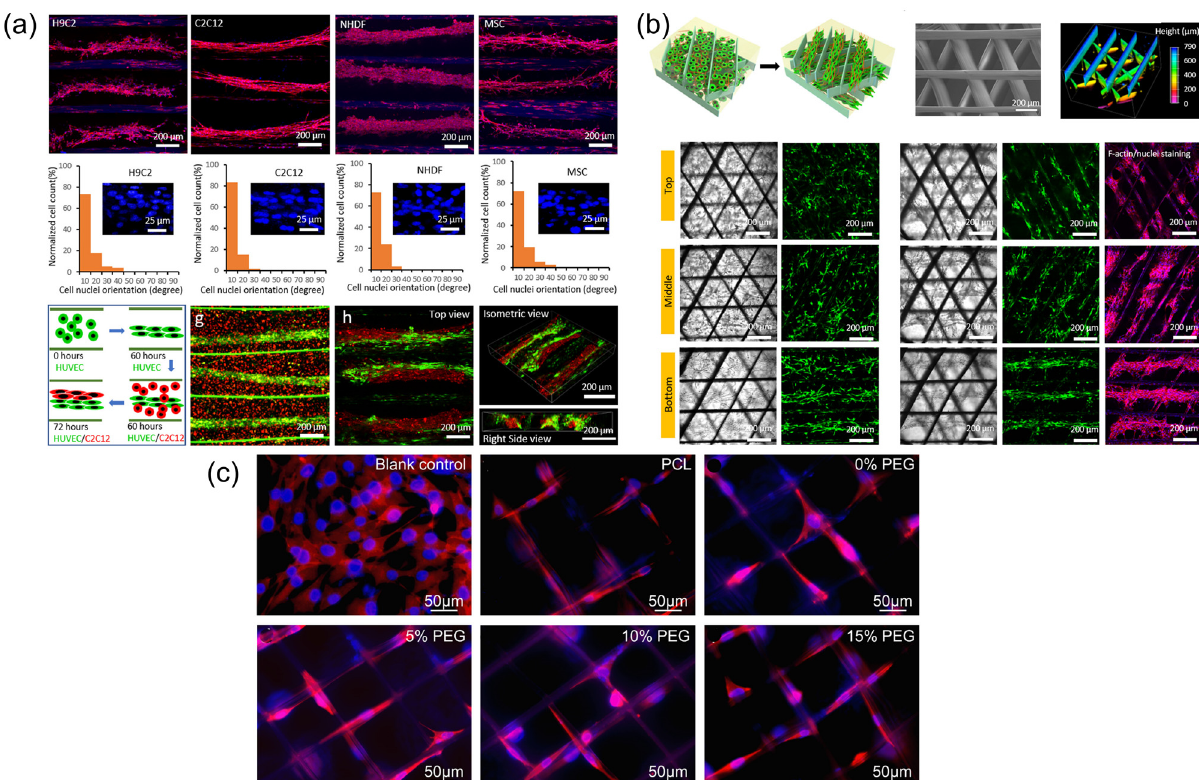
Figure 18: ( a ) The cell growth arrangement image of a single cell type or a plurality of mixed cells cultured in a curved array with 50 printing layers and a pitch of 600 μ m. ( b ) Schematic diagram of the arrangement of three - layer sca ff olds with di ff erent orientations and the activity and morphology images of HUVECs cultured in the bottom, middle, and top three layers. Reproduced from ref. [ 186 ] with permission from Elsevier BV. ( c ) The cell adhesion situation of the stent - free control group, pure PCL stent, and PEG content of 0, 5, 10, and 15% mixed ink stents. Reproduced from ref. [ 191 ] with permission from